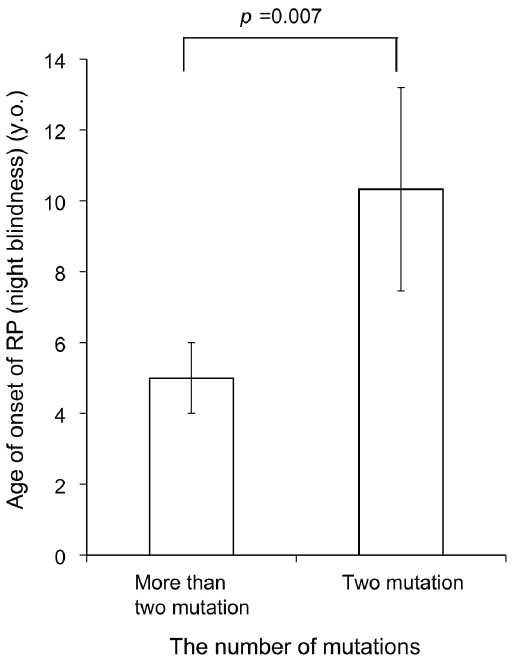
Figure 1. The number of mutations and the age of RP onset in Usher syndrome type 1 patients. The age of RP onset is earlier in the patients with more than two pathogenic mutations. RP: retinitis